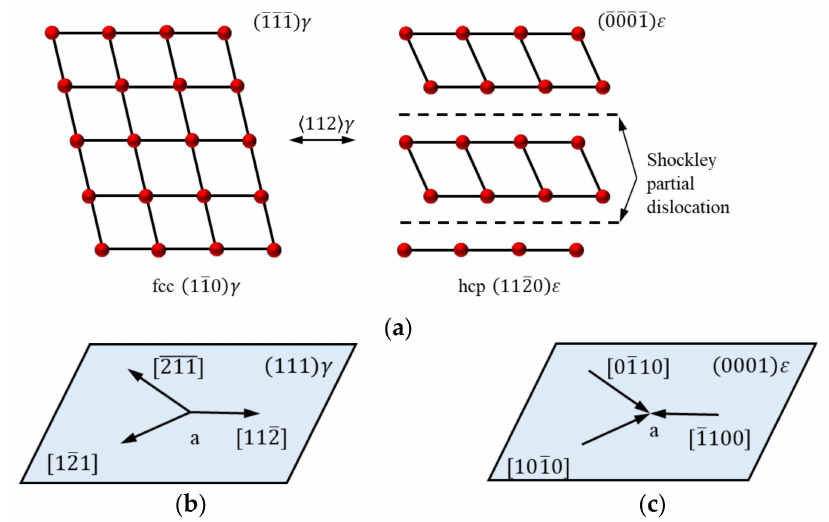
Figure 4. Schematic of martensite transformation and reverse transformation for Shockley partial dislocation movement on (111) in austenite [25,31]: ( a ) Shockley partial dislocation; ( b ) γ (fcc) → ε (hcp); ( c ) ε (hcp) → γ